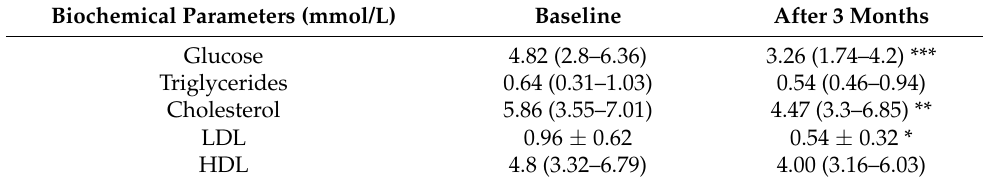
Table 2. Changes in biochemical parameters after treatment.